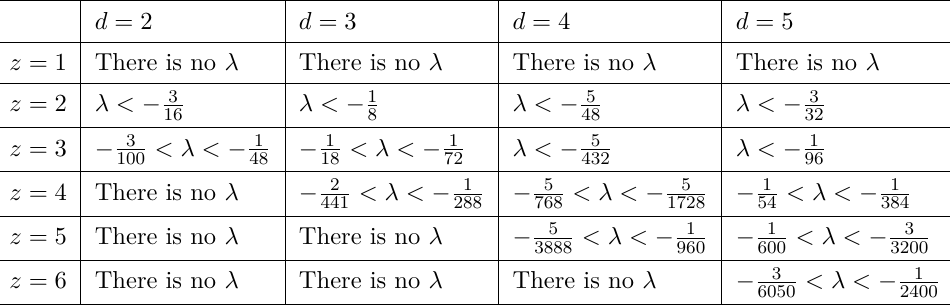
Table 2 . The appropriate ranges of the coupling constant λ for which w fA 2 is a maximum outside the horizon. For some cases, there is no λ .